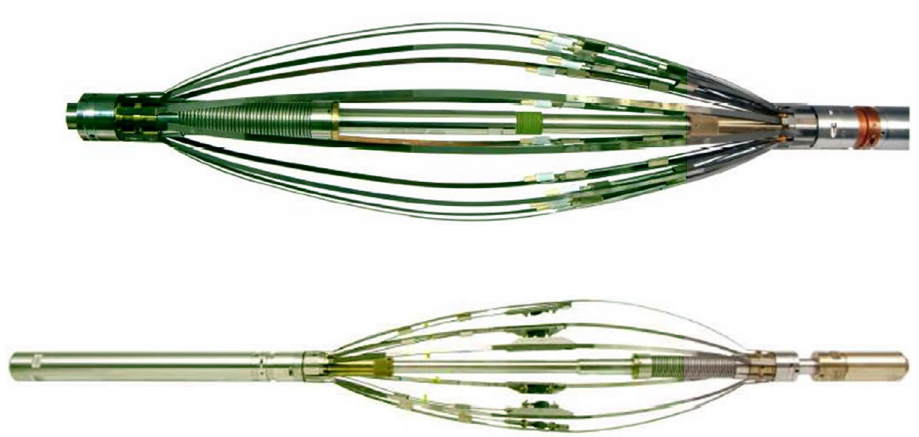
Fig. 3 General views of capaci- tance array tool (CAT)